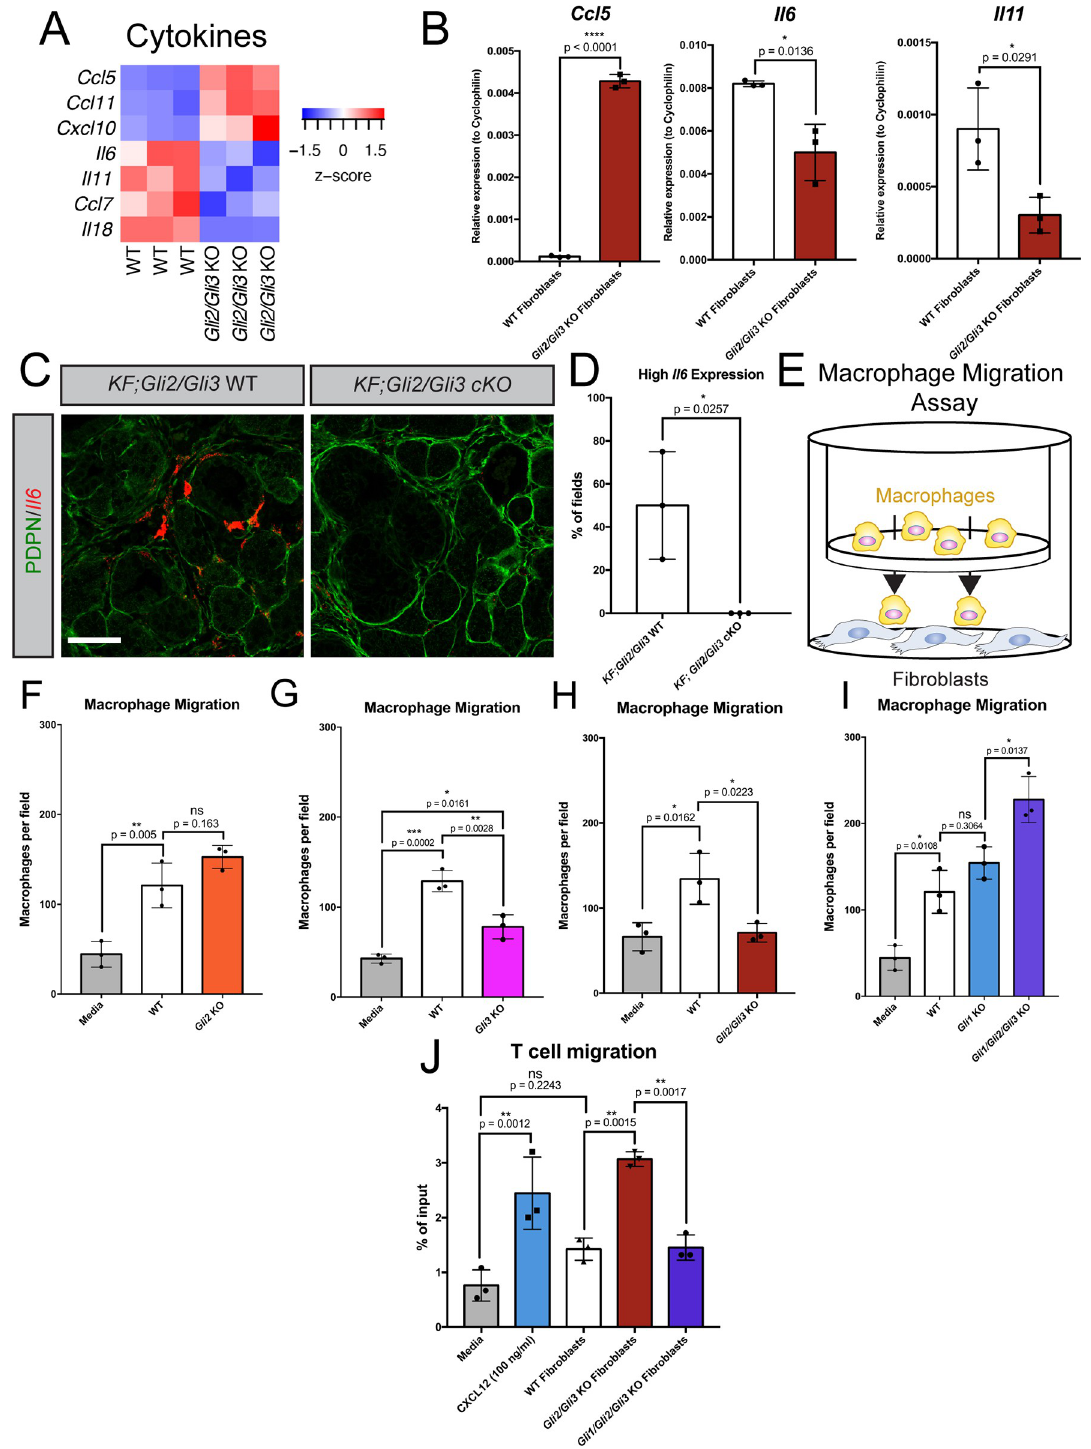
Fig 6. Gli1 -3 in fibroblasts directly control macrophage and T cell migration. A ) Differential expression of cytokines in Gli2/Gli3 WT and Gli2/Gli3 KO fibroblasts, as determined by RNA sequencing. B ) qPCR analysis of Ccl5 (left) and Il6 (center) and Il11 (right) in Gli2/Gli3 WT and Gli2/Gli3 KO fibroblasts. C ) Il6 expression (red) by fibroblasts (PDPN, green) in KF;Gli2/Gli3 WT and KF;Gli2/Gli3 cKO mice, as determined by RNAscope. Scale bar = 50 μ m D ) Quantification of high Il6- expressing fields of view in in KF;Gli2/Gli3 WT and KF;Gli2/Gli3 cKO mice (n = 3 for each genotype). High Il6 expression defined as an integrated density value (for the Il6 probe